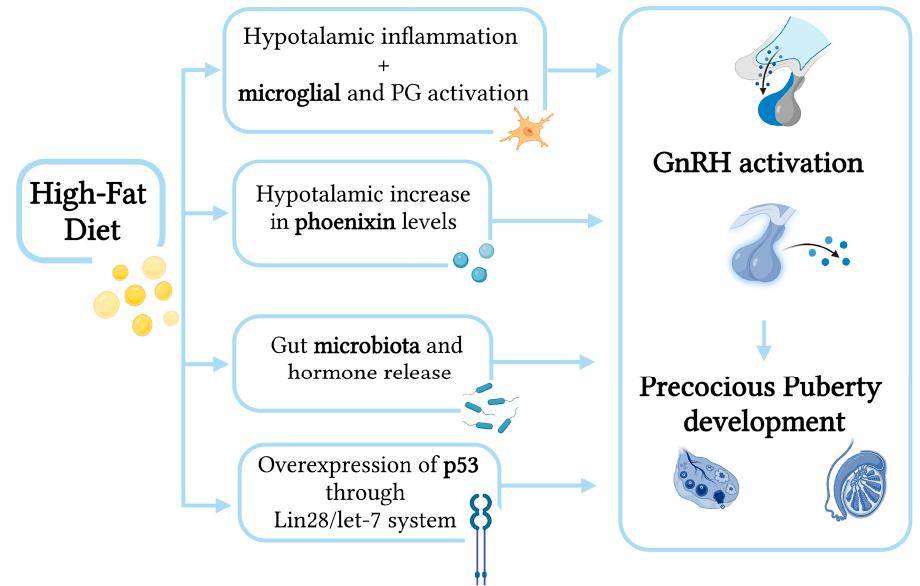
Figure 2. Mechanisms by which a high-fat diet promotes precocious puberty. 5.2.1. Activation of GnRH via Hypothalamic Microglial Cells HFD causes hypothalamic inflammation and microglial cell activation. Valdearcos et al. determined that microglia of the hypothalamus are sensitive to fatty acids (FAs) in murine models [22]. The researchers demonstrated that mice’s microglial cells undergo inflammatory activation with a diet rich in saturated FAs [18,24]. Interestingly, FAs (and not obesity per se) induce microglial activation, as shown by Gao et al., who demonstrated that genetically obese mice do not show hypothalamic microglia activation when not fed an HFD [133,134]. Microglial cells play a key role in PP, as these cells communicate with GnRH cells. This intercellular communication was mediated by prostaglandins [23]. GnRH, secreted following a pulsatile pattern from the hypothalamus, leads to the secre- tion of LH and FSH from the anterior pituitary gland. In conjunction with estradiol and testosterone, these hormones promote oogenesis and spermatogenesis, respectively [23,24]. In addition, microglial cells also enhance the production of brain-derived neu- rotrophic factors (BDNF) for several neurons, among which are the gonadotrophic axis in the preoptic area and the pituitary gland [25]. 5.2.2. Activation of GnRH via Diet-induced Phoenixin Action